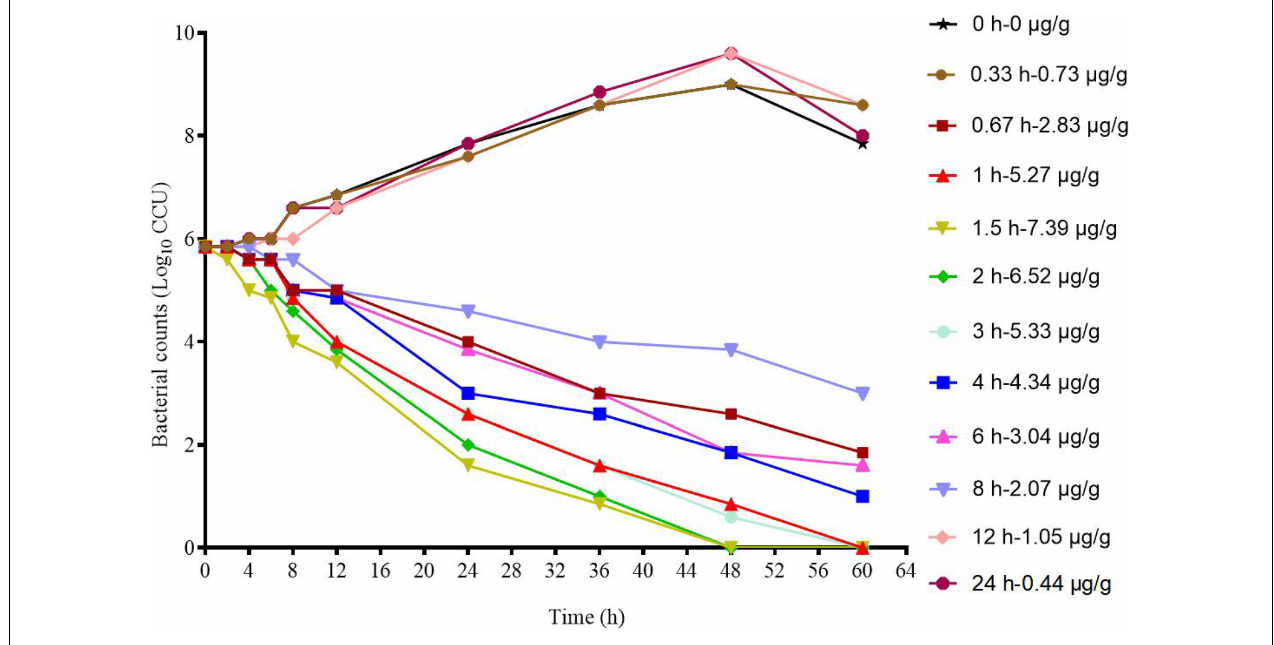
FIGURE 4 | Ex vivo killing–time curves of tylosin against M17 in infected lung tissue.